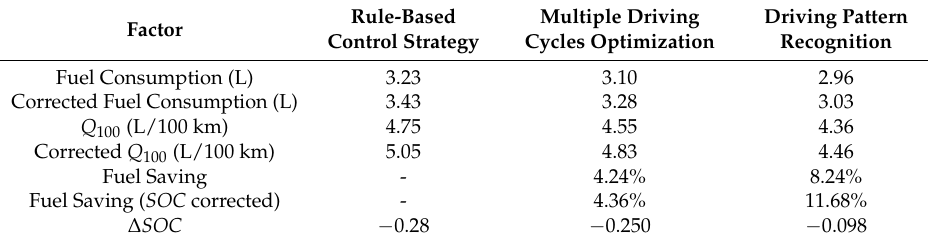
Table 11. Fuel economy comparison results.